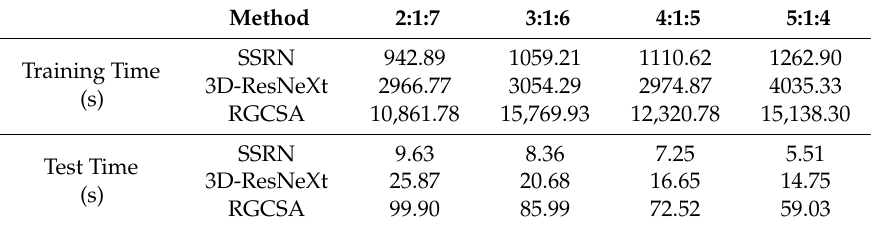
Table 15. Training time and test time for di ff erent networks in the IN dataset.